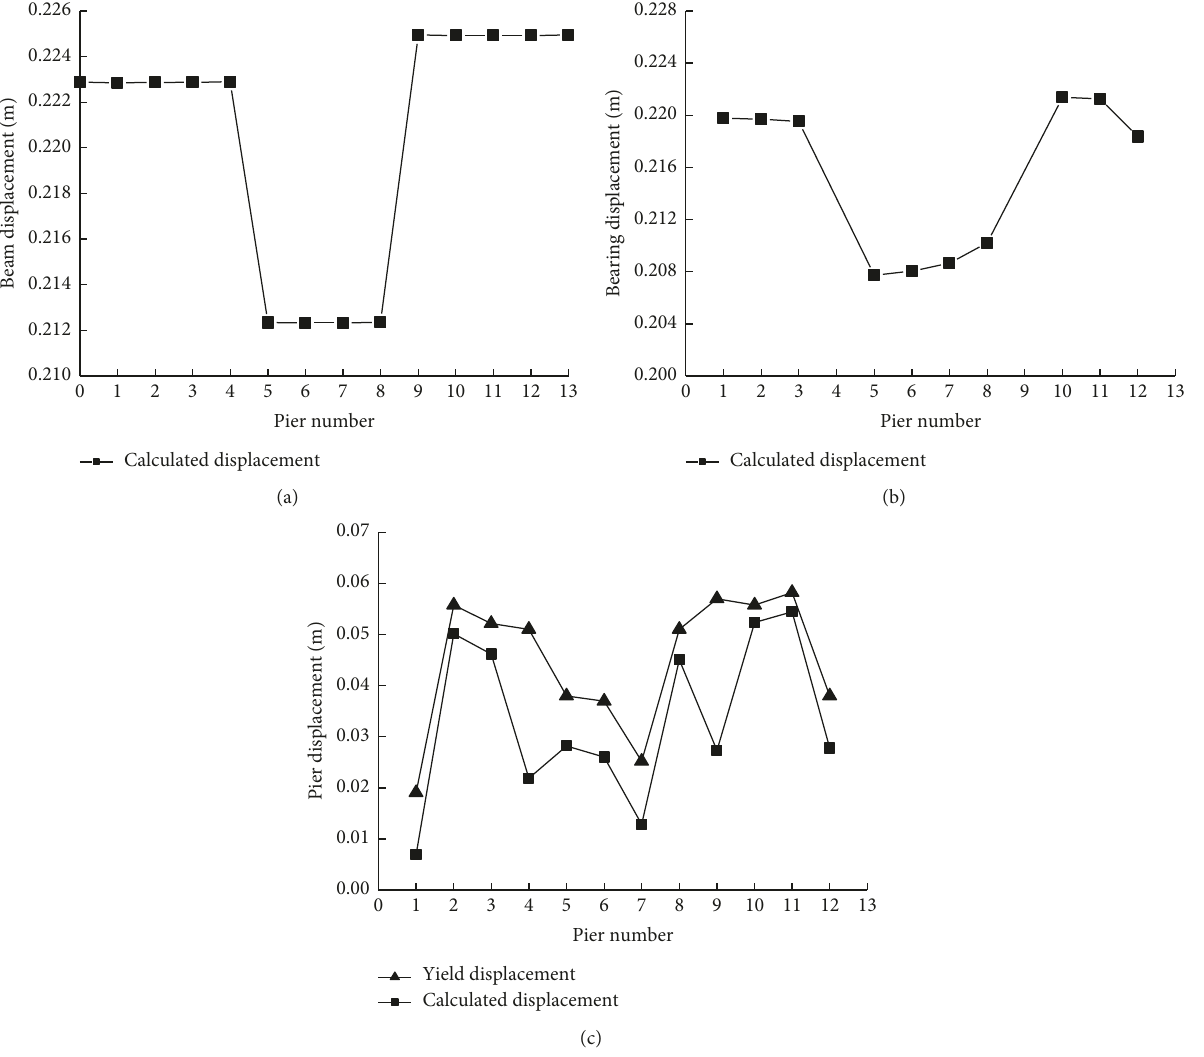
Figure 8: Displacement response under design earthquake. (a) Girder displacement. (b) Bearing displacement. (c) Pier